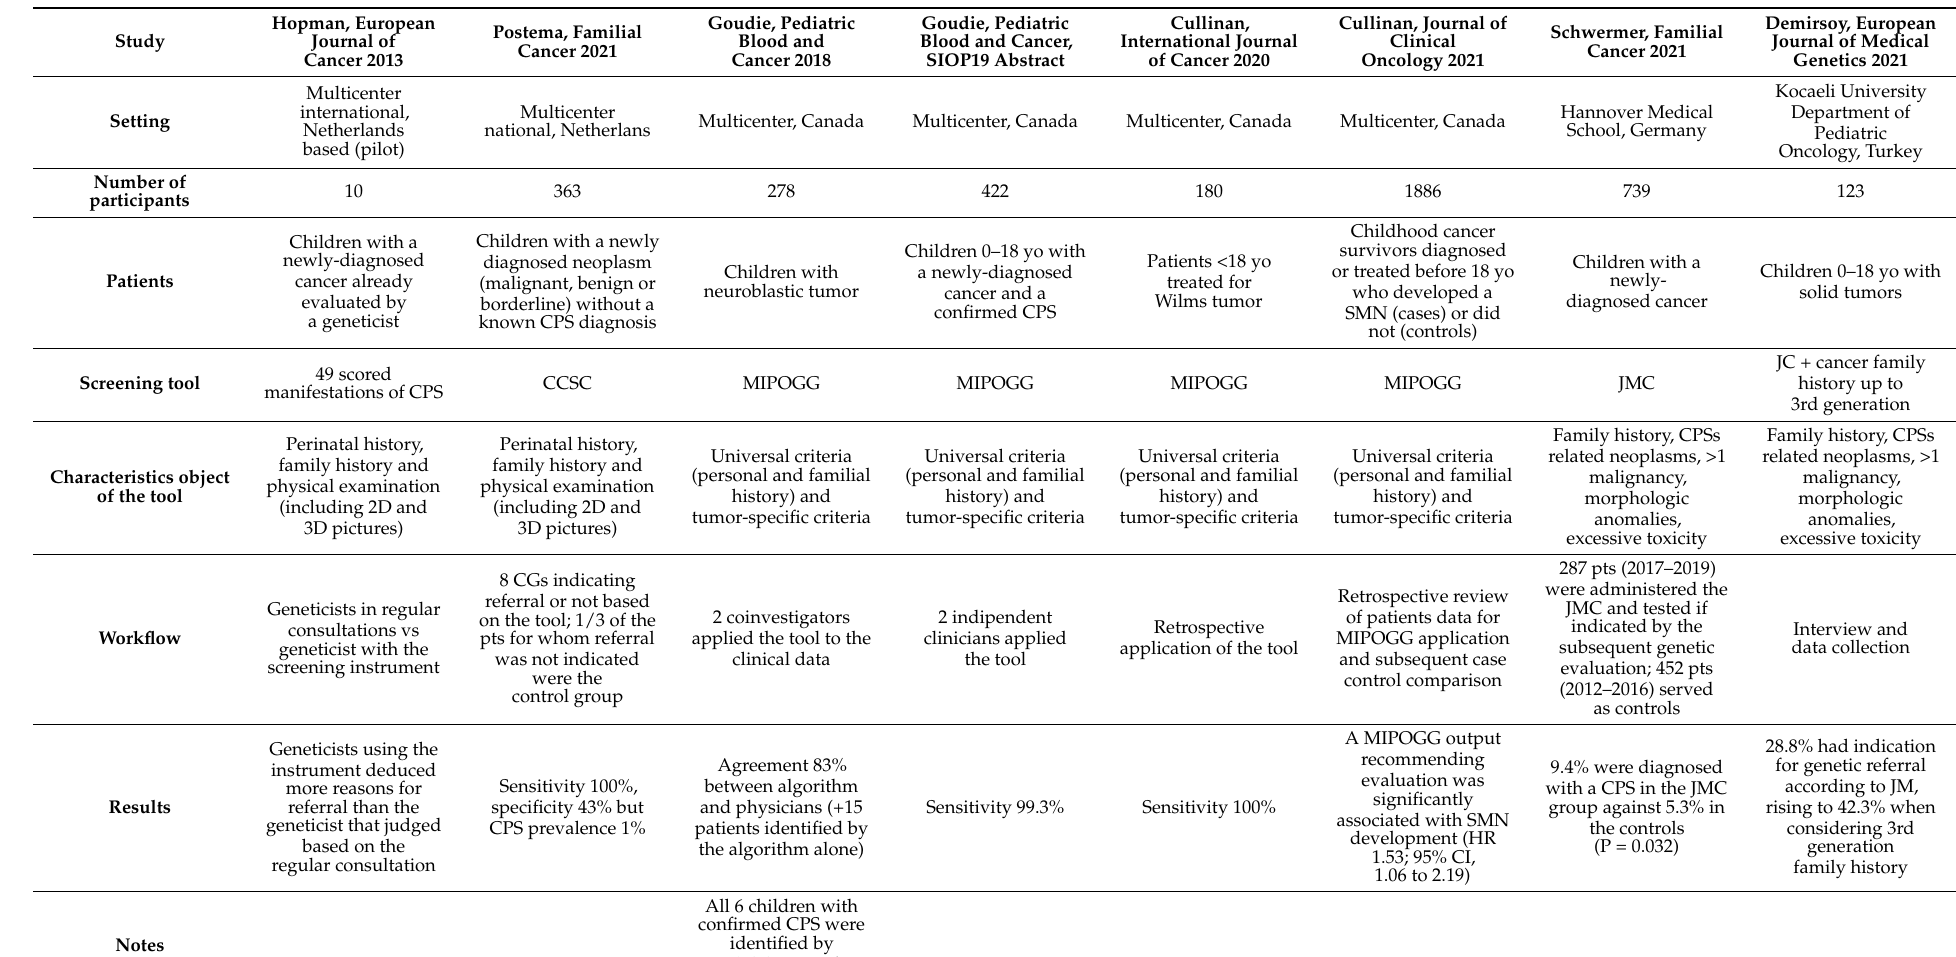
Table 3. Results of studies evaluating the use of clinical screening